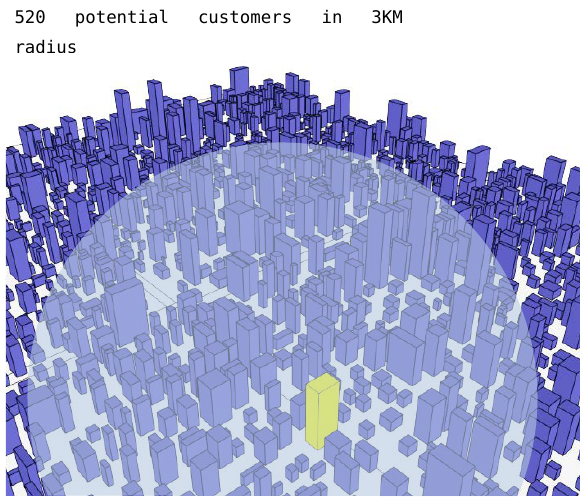
Figure 8. Potential customer within 3KM radius from new opening store (yellow block).